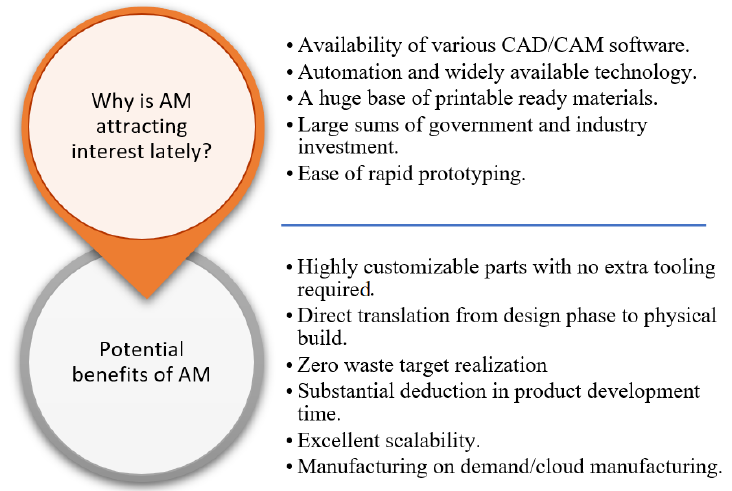
Figure 1. Prospects of additive manufacturing.